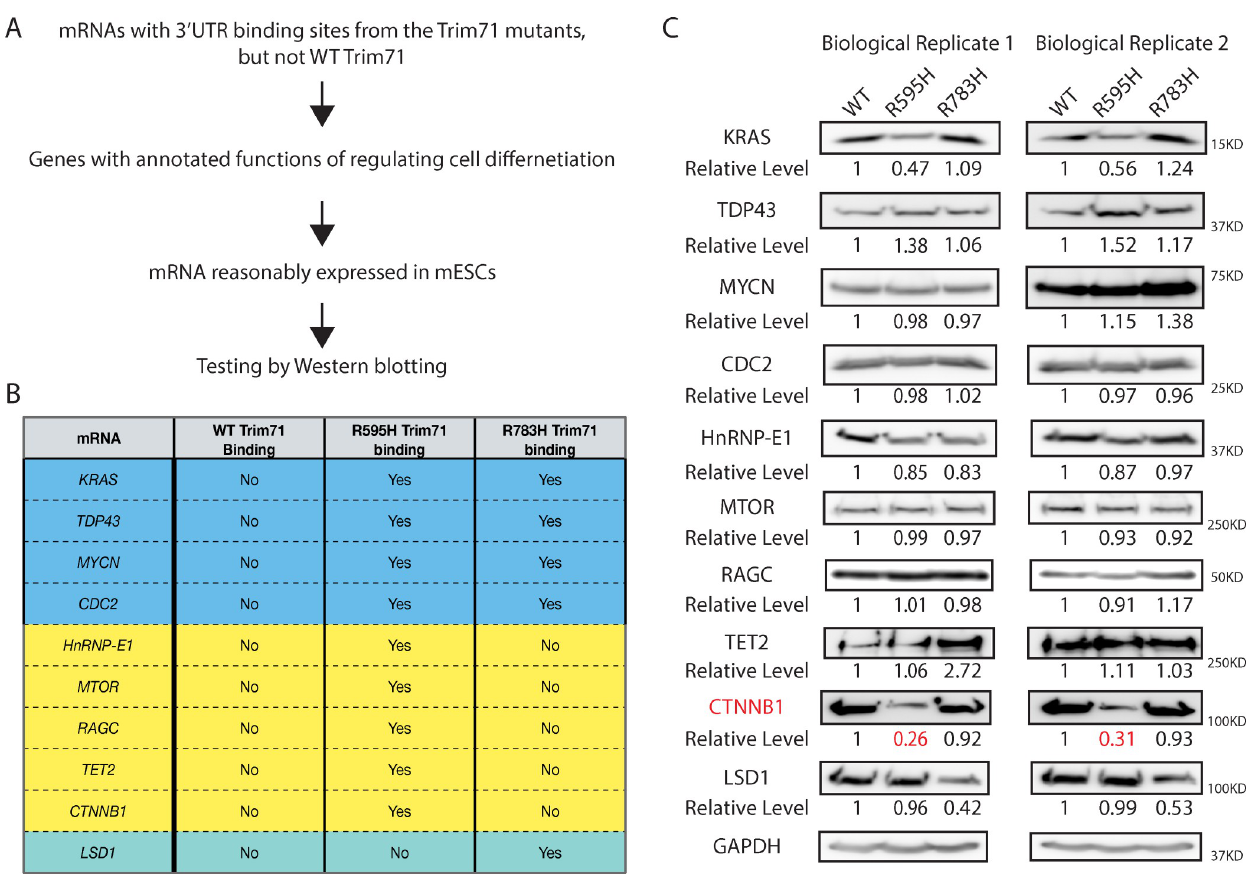
Fig 3. Identification of candidate genes for functional characterization. ( A ) Outline of strategies to identify potential functional targets of the Trim71 mutants. ( B ) A table summarizing the selected candidate mRNAs with binding sites from the Trim71 mutants. ( C ) Western blots in the WT, R595H Trim71, and R783H Trim71 mESCs cultured in 2i + Lif medium. GAPDH was used for normalization in determining the relative protein levels. mESC, mouse embryonic stem cell; WT,